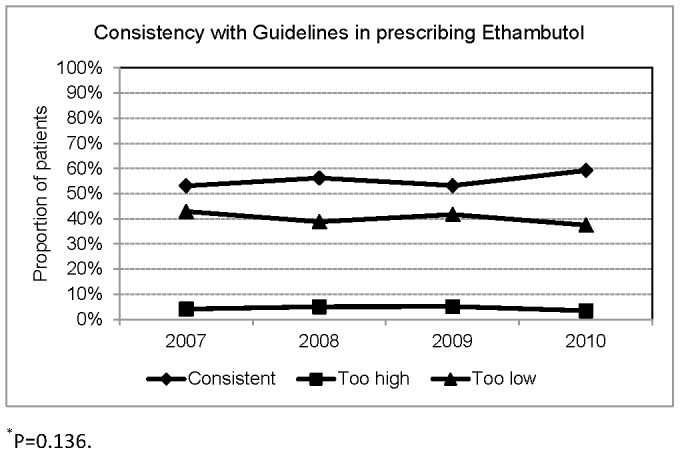
Consistency with Taiwan Guidelines in prescribing Ethambutol.